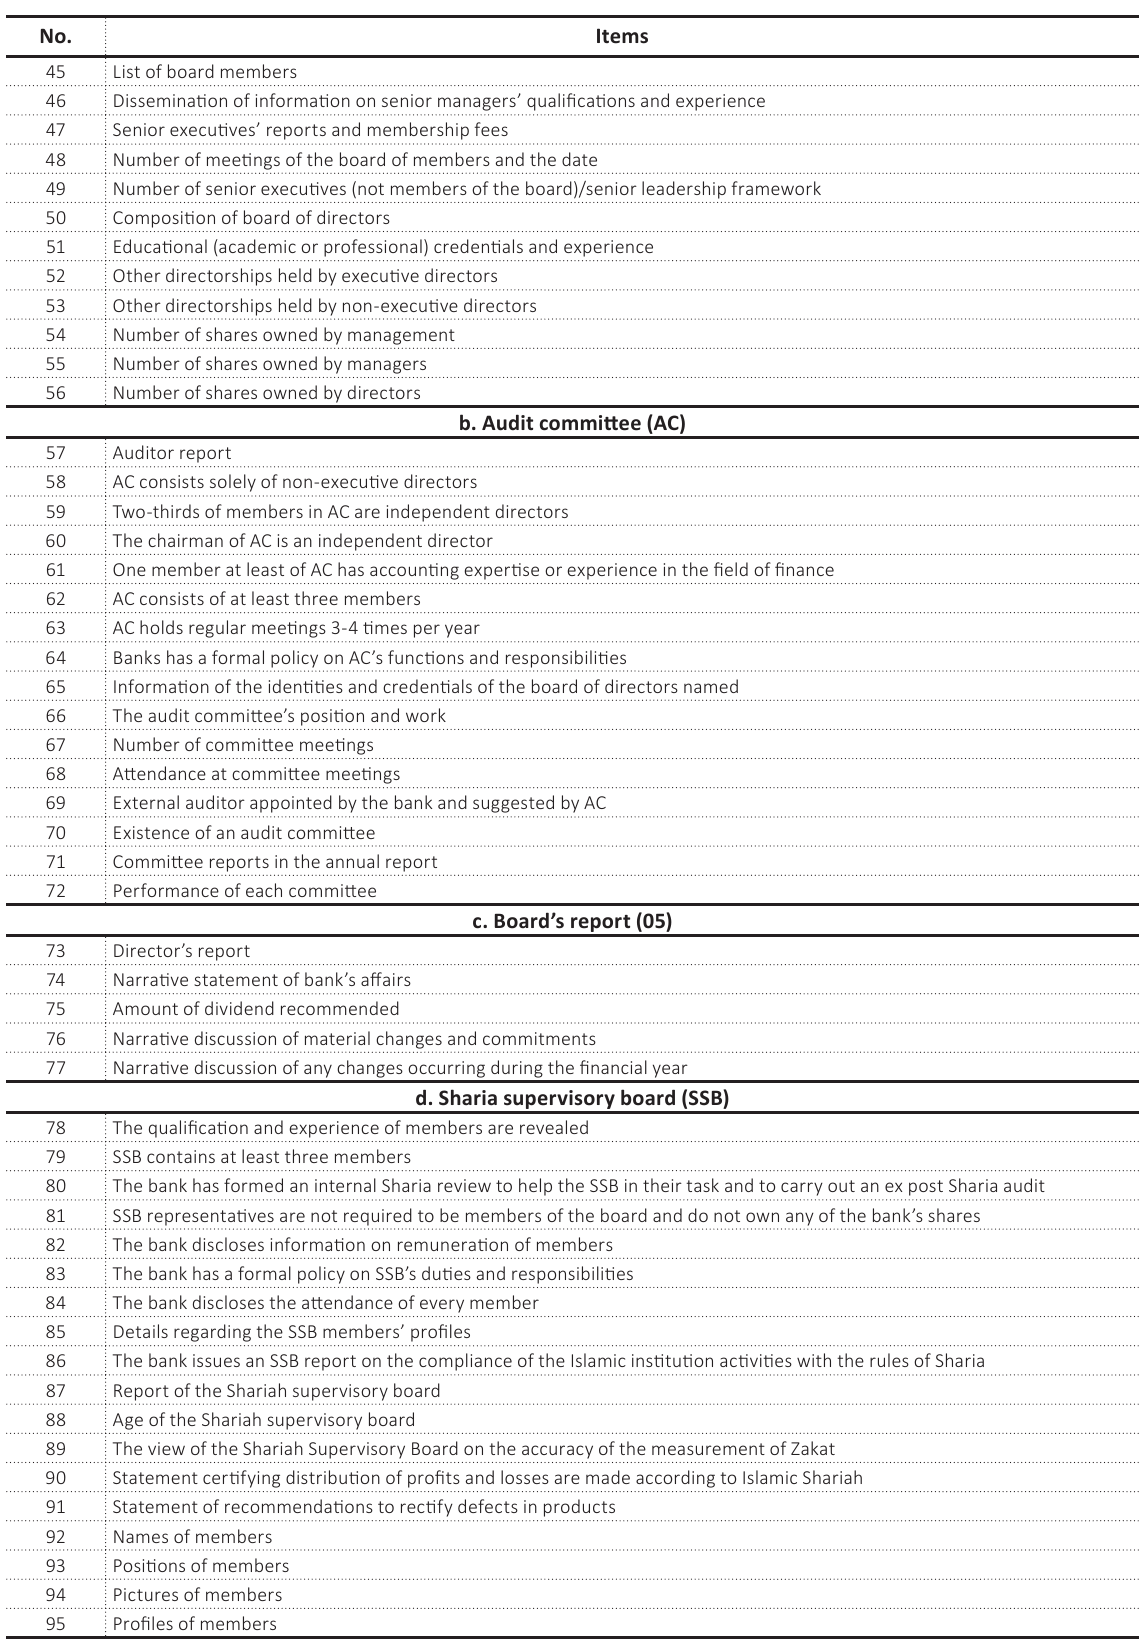
Table A1. (cont.) Voluntary disclosure index